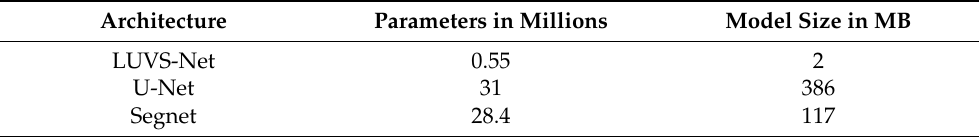
Table 3. A comparison of the number of parameters and model size.